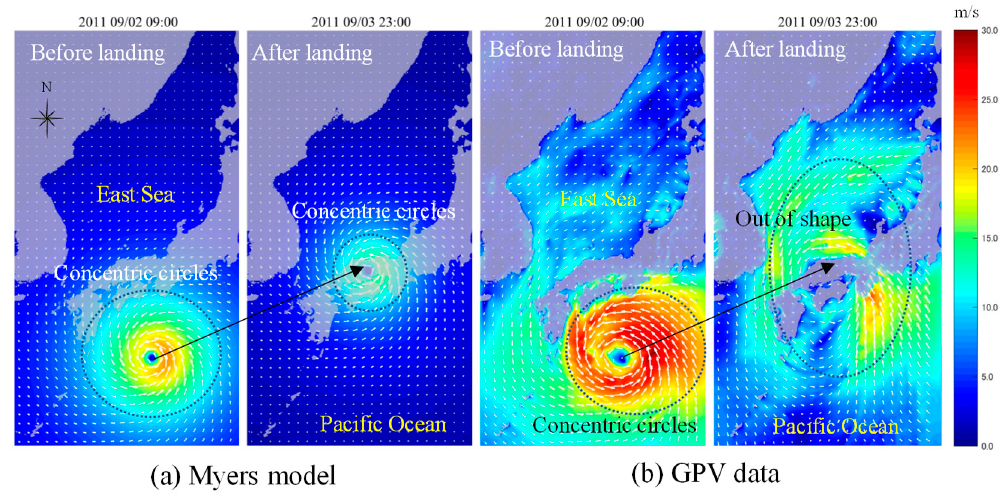
Figure 8. Typhoon shape changes based on terrain topography.